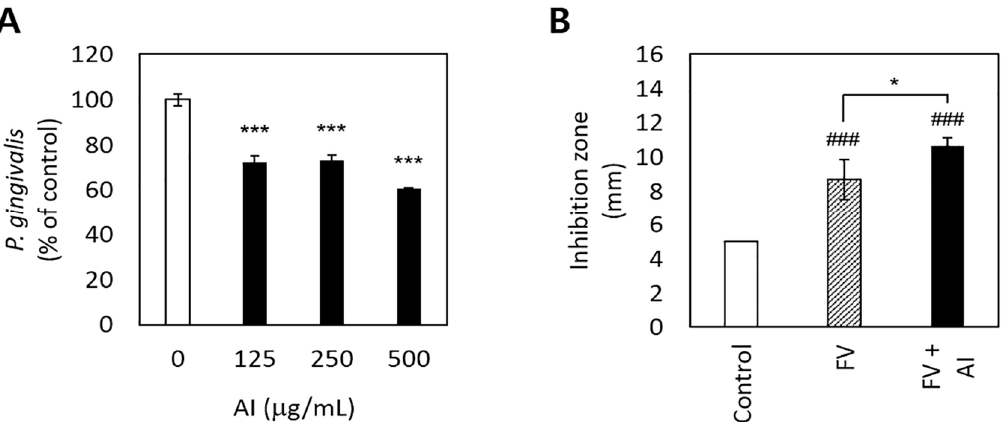
Figure 2. Antibacterial effects of and the sustainability of antibacterial activity by Asplenium incisum (AI). ( A ) Inhibitory effects on Porphyromonas gingivalis growth according to the concentration of the AI extract. ( B ) Sustained inhibitory effects of AI against P. gingivalis on the agar diffusion test after 3 days. *** Indicates a significant difference from the 0 μ g/mL AI extract group ( p < 0.001). ### Indicates a significant difference from the control (film disc per se) group ( p < 0.001). * Indicates a significant difference between the fluoride varnish (FV) and FV + AI groups ( p < 0.05).